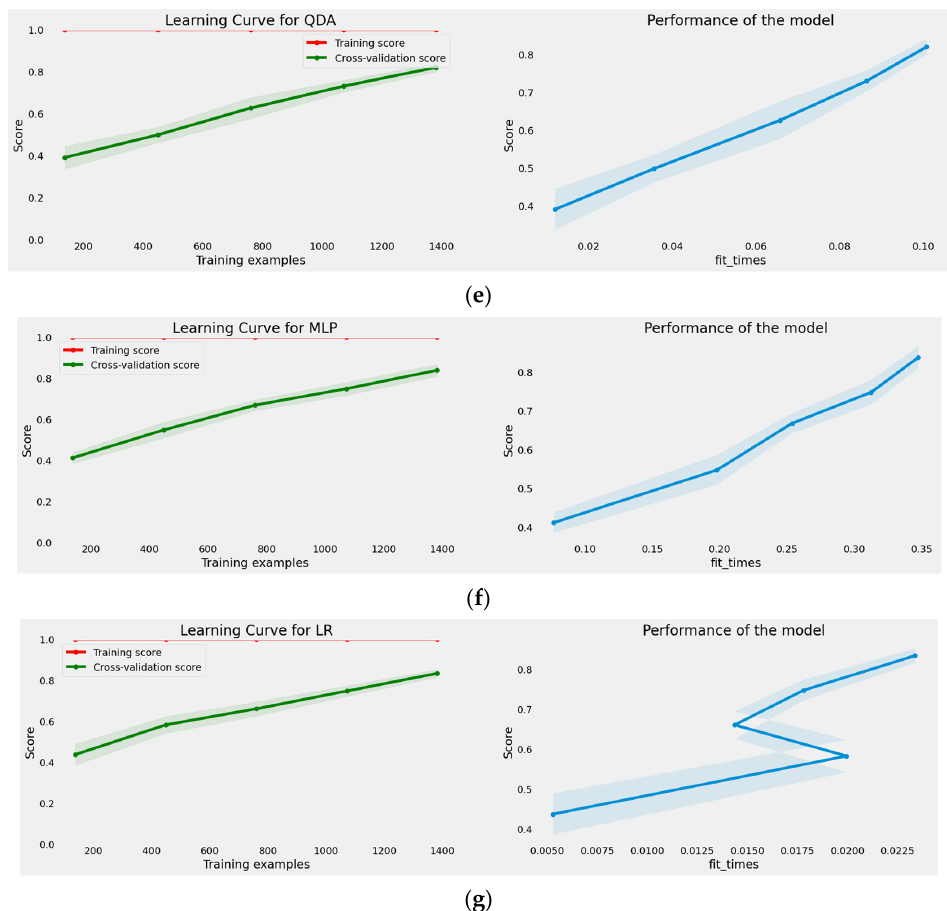
Figure 9. Multiclass learning and performance curves of the proposed machine learning models. ( a ) Learning Curve and Performance plots of The Proposed SVM Model. ( b ) Learning Curve and Performance plots of The Proposed RF Model. ( c ) Learning Curve and Performance plots of The Proposed DT Model. ( d ) Learning Curve and Performance plots of The Proposed KNN Model. ( e ) Learning Curve and Performance plots of The Proposed QDA Model. ( f ) Learning Curve and Performance plots of The Proposed QDA Model. ( g ) Learning Curve and Performance plots of The Proposed LR Model.